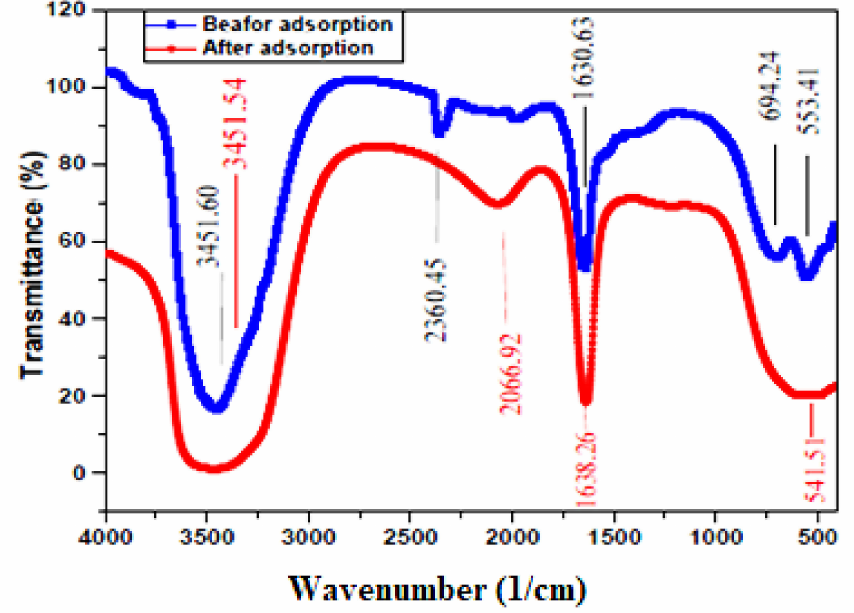
Figure 3. Fourier-transform infrared spectroscopy (FTIR) spectra of the Nd 2 O 3 nanoparticles before adsorption (up) and after adsorption